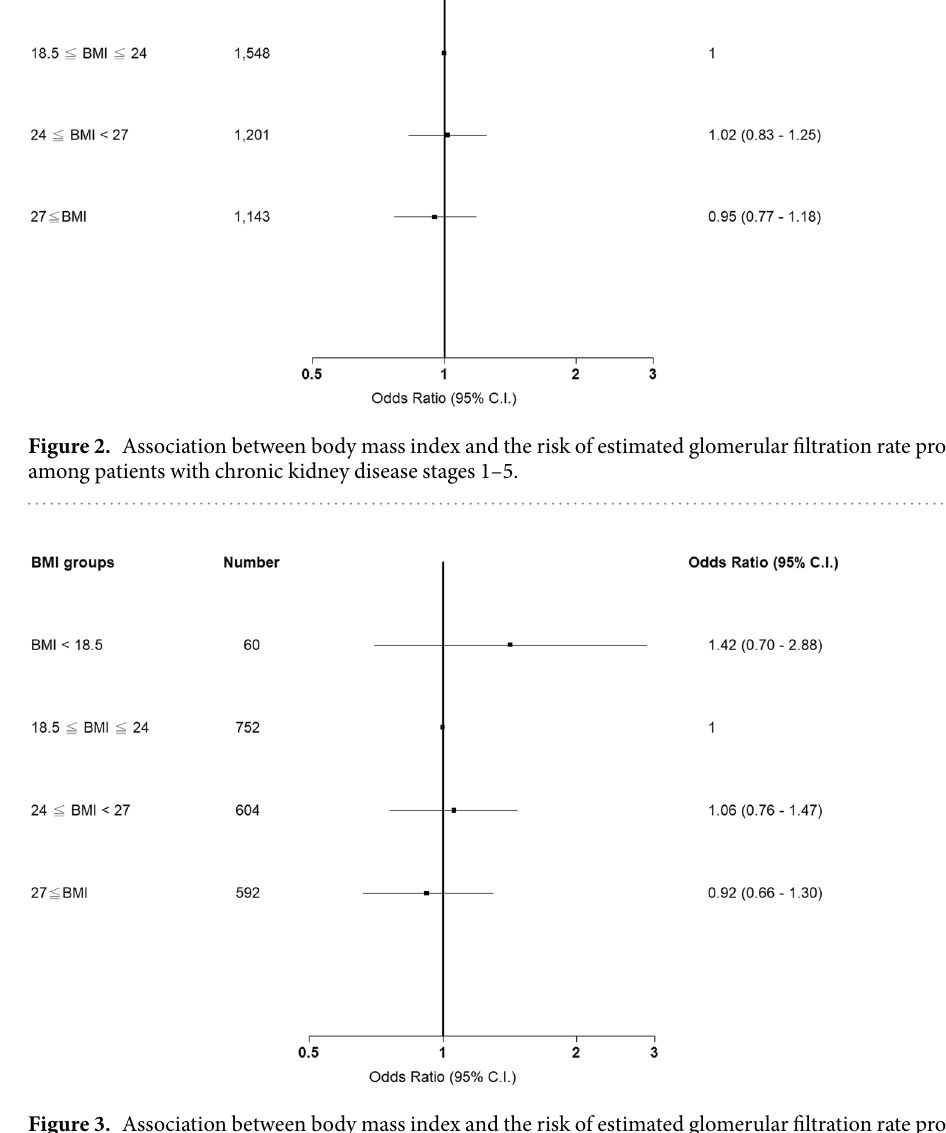
Figure 3. Association between body mass index and the risk of estimated glomerular filtration rate progression among patients with chronic kidney disease stages